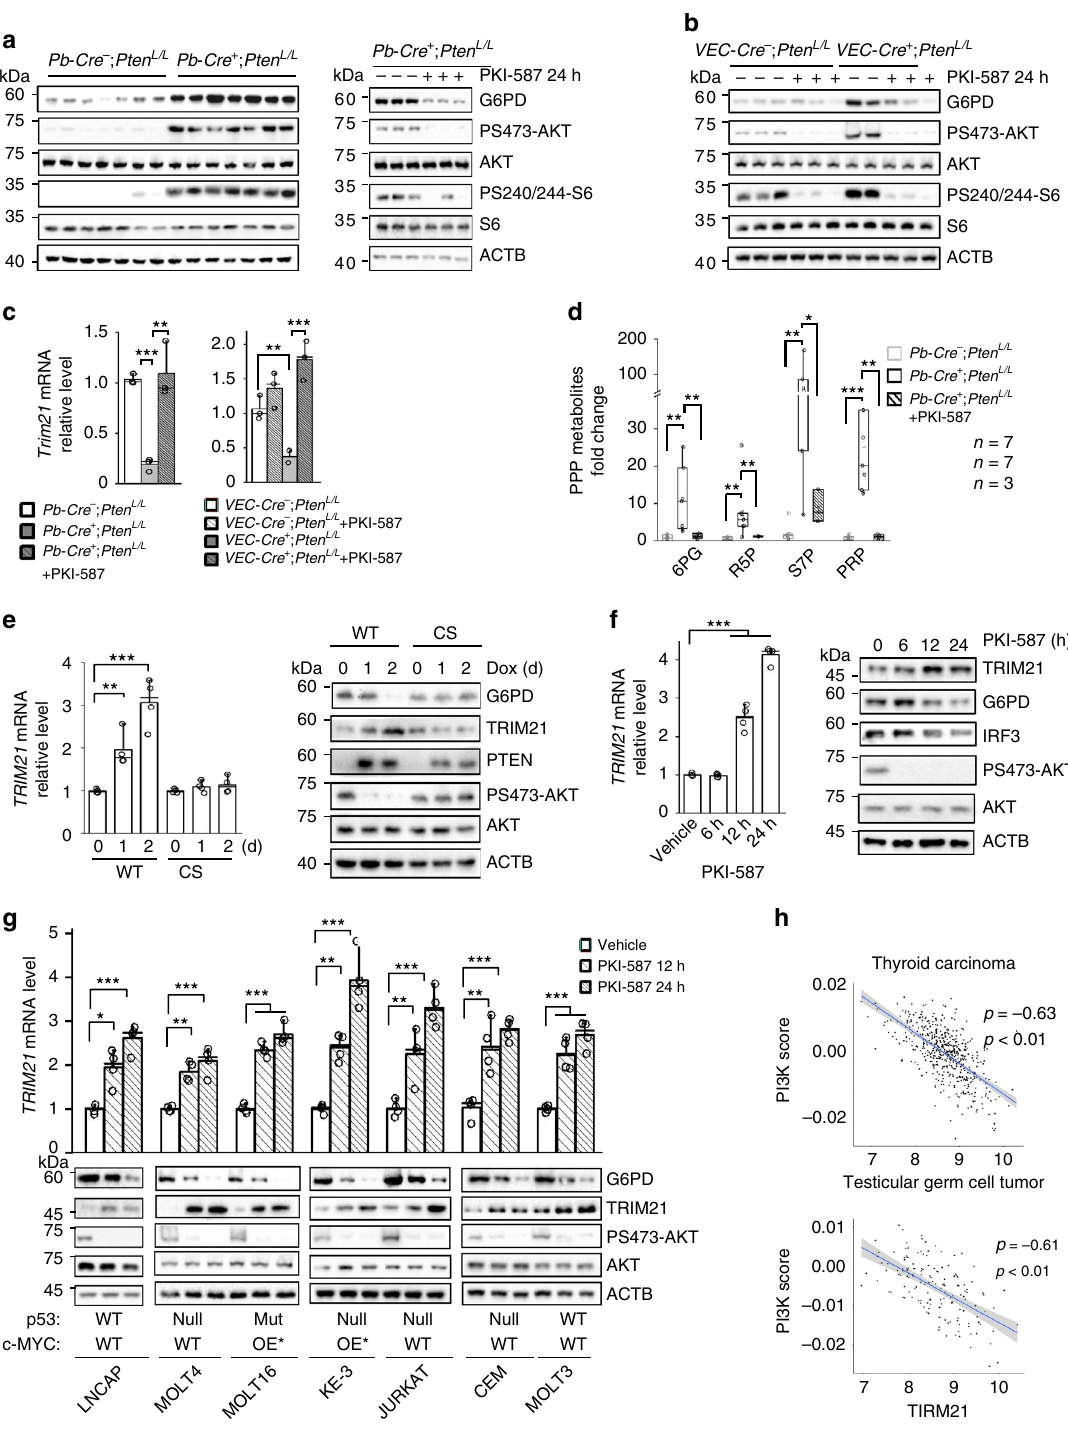
association with the 6-AN- or PKI-587-mediated AKT inhibition, the phospho-H3 levels were signi fi cantly decreased, while the c- CASPASE3 levels were signi fi cantly increased (Fig. 5b). However, 6-AN treatment had no effect on the ERK and PDK1 activities, suggesting an AKT-speci fi c effect (Fig. 5b, right panel). We also tested the association between the PPP and AKT activity in the PTEN null human prostate cancer and T-ALL cell lines. We found that 6-AN treatment substantially decreased the P-AKT levels, similar to the effects of PKI-587 treatment